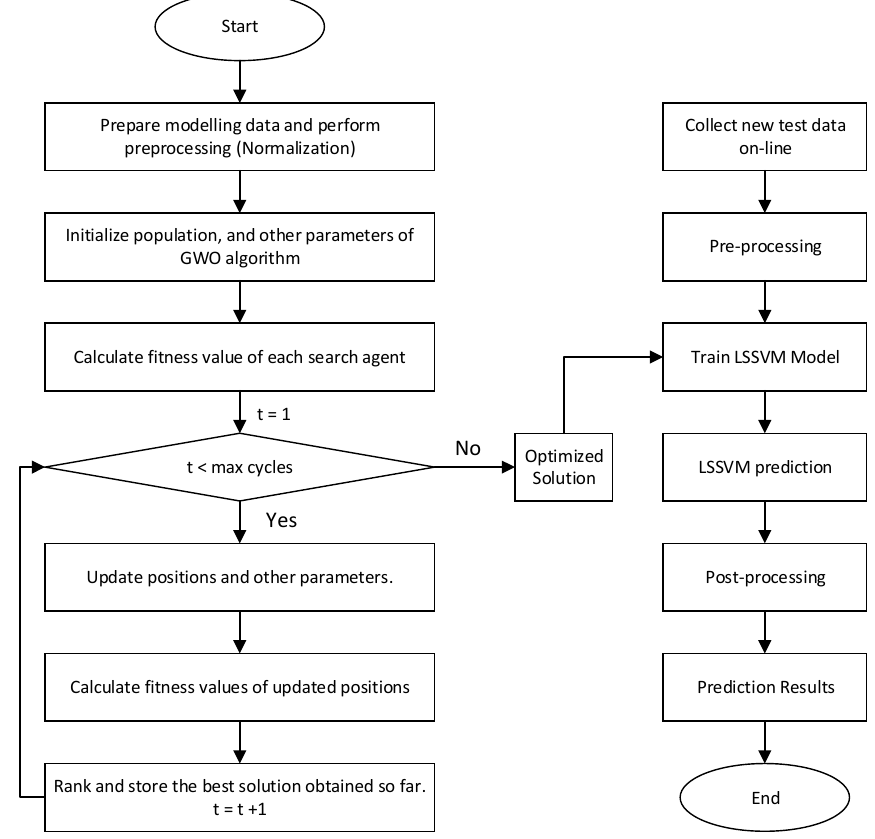
Figure 2. GWO-LSSVM prediction